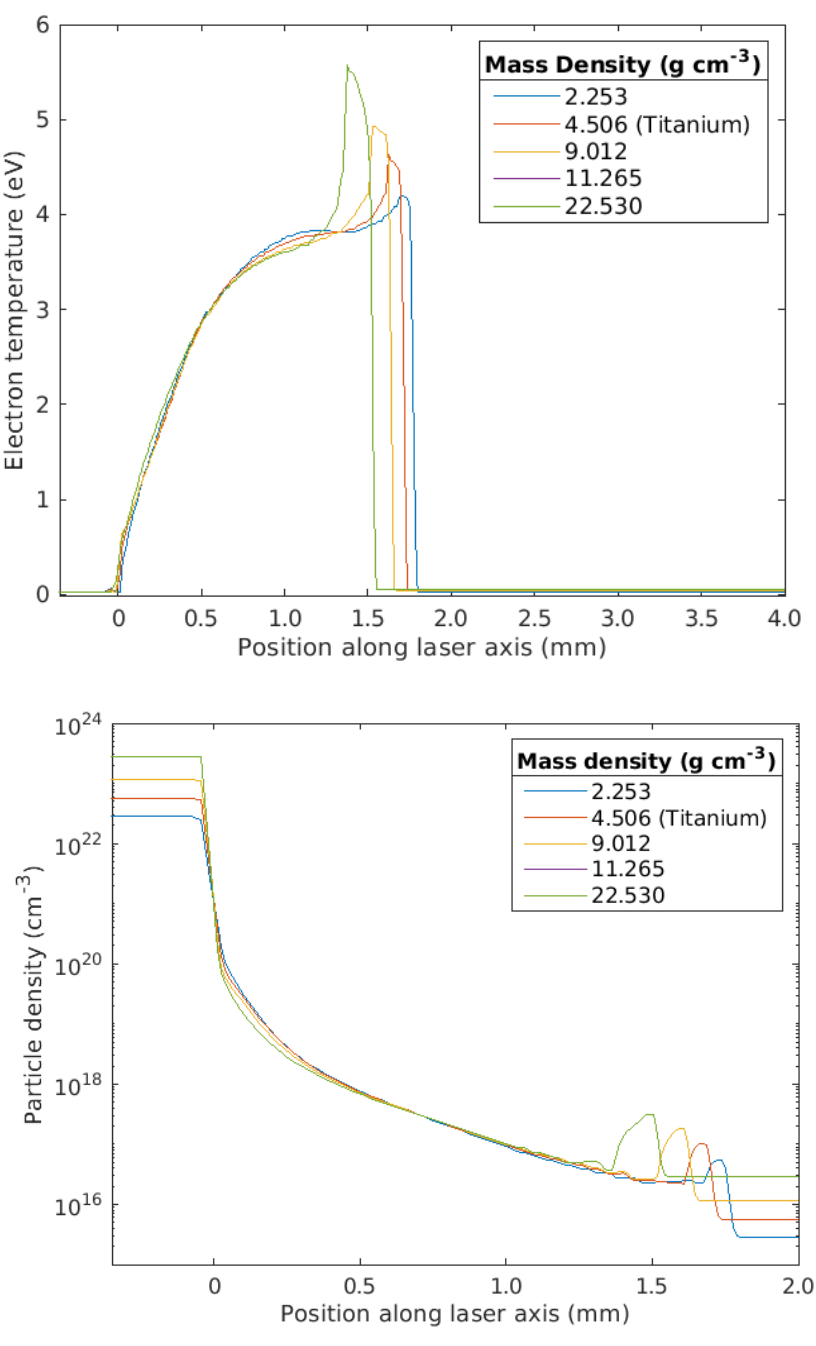
Figure 5. 1D plot comparing the spatial distribution of the electron temperature ( top ) and the particle density ( bottom ) of an ablated titanium plasma plume with varied mass density 25 ns after the laser pulse. The default mass density of titanium is 4.506 g cm − 3 . The laser fluence was 100.5 J cm − 2 and the laser focus was 100 µ